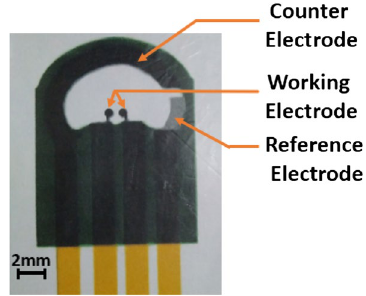
Figure 12. The schematic representation of the